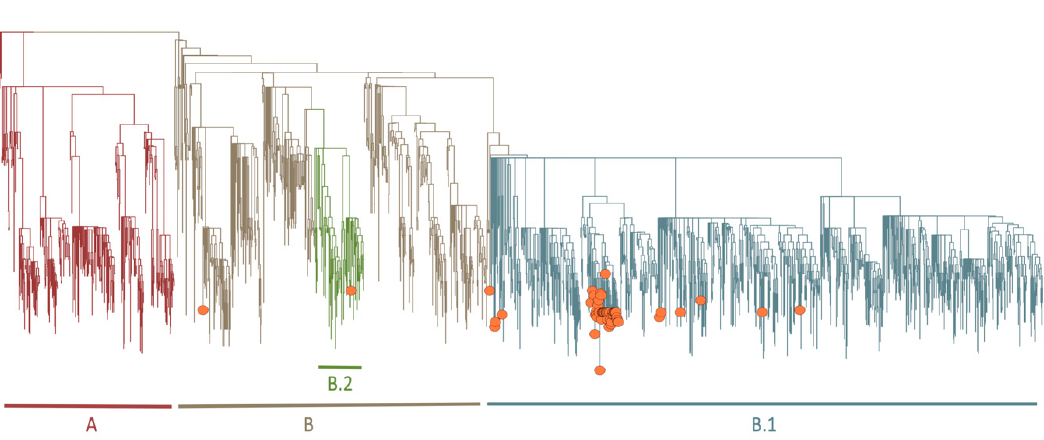
Figure 5. Phylogenetic tree. Showing a Maximum-Likelihood (ML) tree of the 54 genomes (orange circles) against publicly available SARS-CoV-2 genomes as reference. The 54 genomes fall mostly in the B.1 ( n = 50), B ( n = 3), or B.2 ( n = 1) lineages.